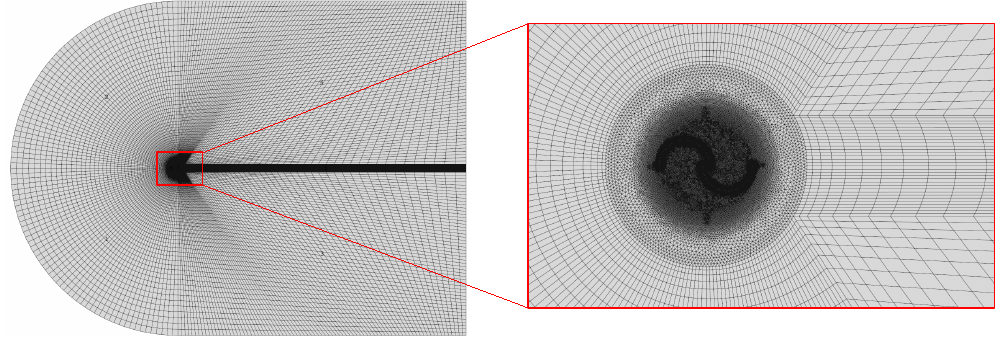
Figure 4. Structured mesh